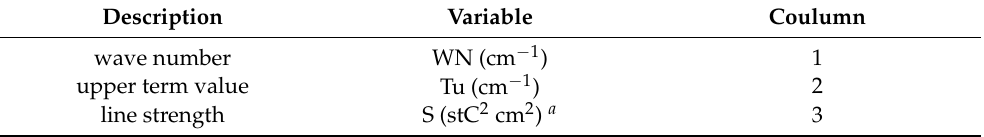
Table 5. Line-strength data contents: Vacuum wave numbers and upper term values, line strengths.